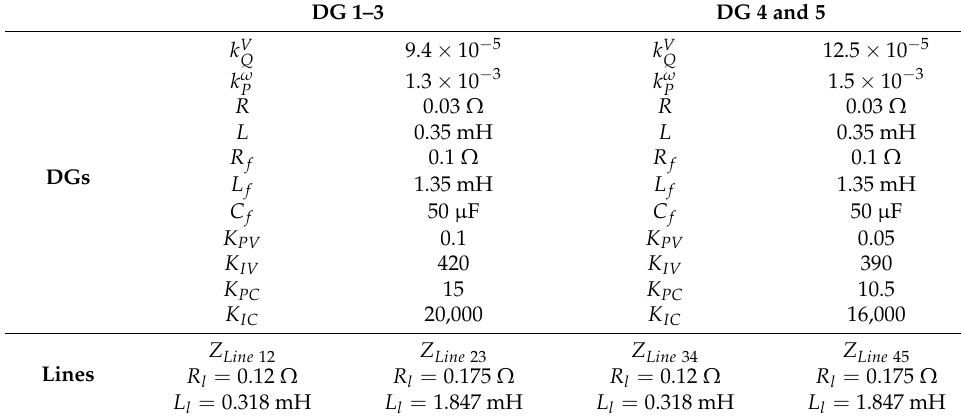
Table 1. Parameters of MG Test System.